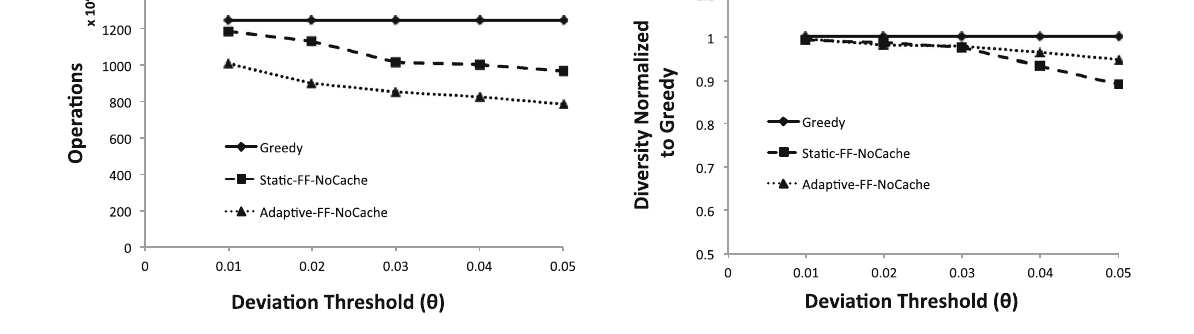
Fig. 10 Impact of h on cost and diversity